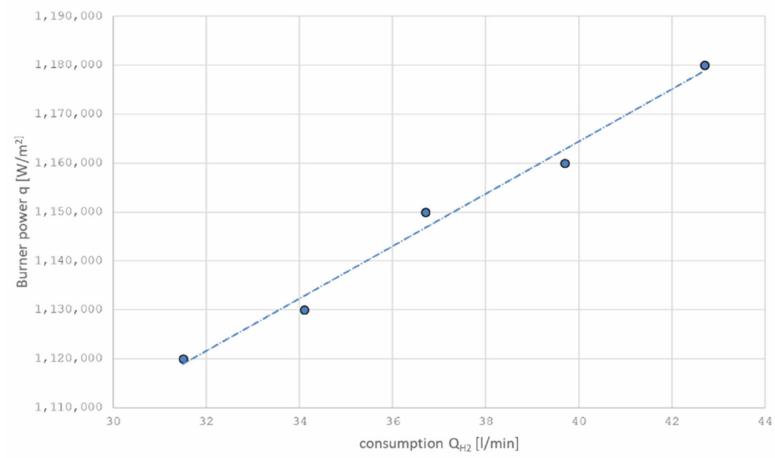
Figure 14. The dependence of the power q max on the consumption Q H2 with a mobile